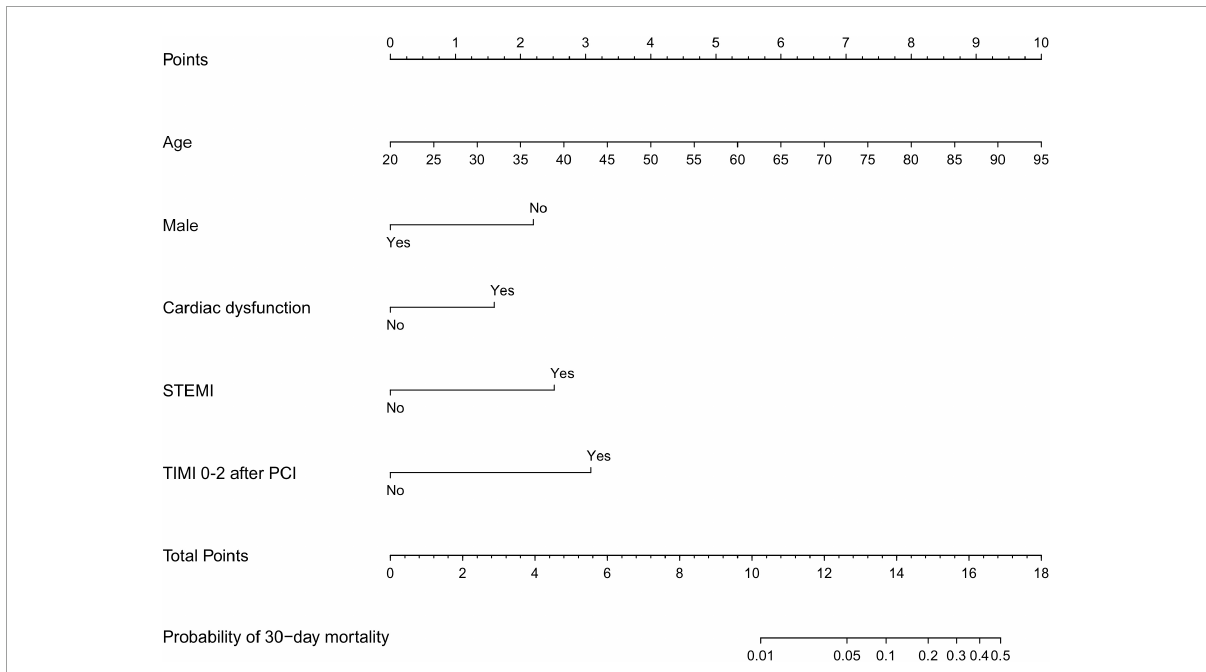
FIGURE1 Nomogram scores of 30-day mortality. Nomogram for predicting the probability of 30-day mortality after PCI. Points were assigned for age, male sex, cardiac dysfunction, STEMI, and TIMI 0–2 after PCI by drawing a line upward from the corresponding values to the “points line”. The “total points” are calculated as the sum of the individual score of each of the five variables included in the nomogram. STEMI, ST-segment elevation myocardial infarction; TIMI, thrombolysis in myocardial infarction; PCI, percutaneous coronary intervention. Cardiac dysfunction was defined as LVEF < 50%.